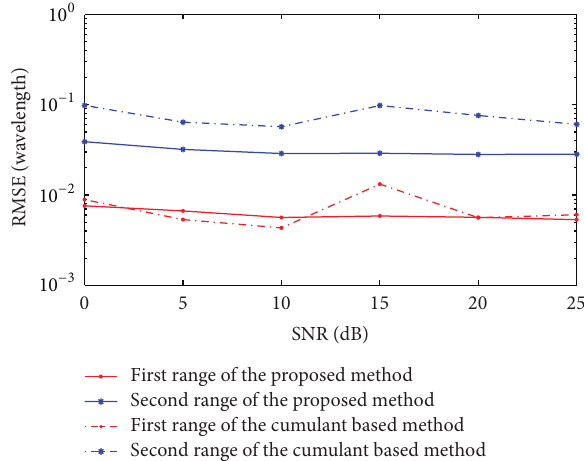
Figure 4: The RMSE of range estimations for two near-field sources using the proposed method and the cumulant based method versus SNR.